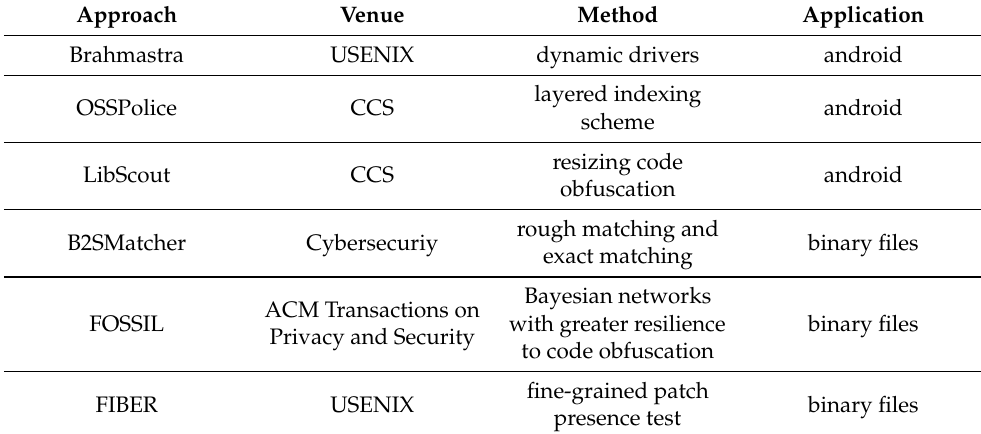
Table 2. Open-source vulnerability